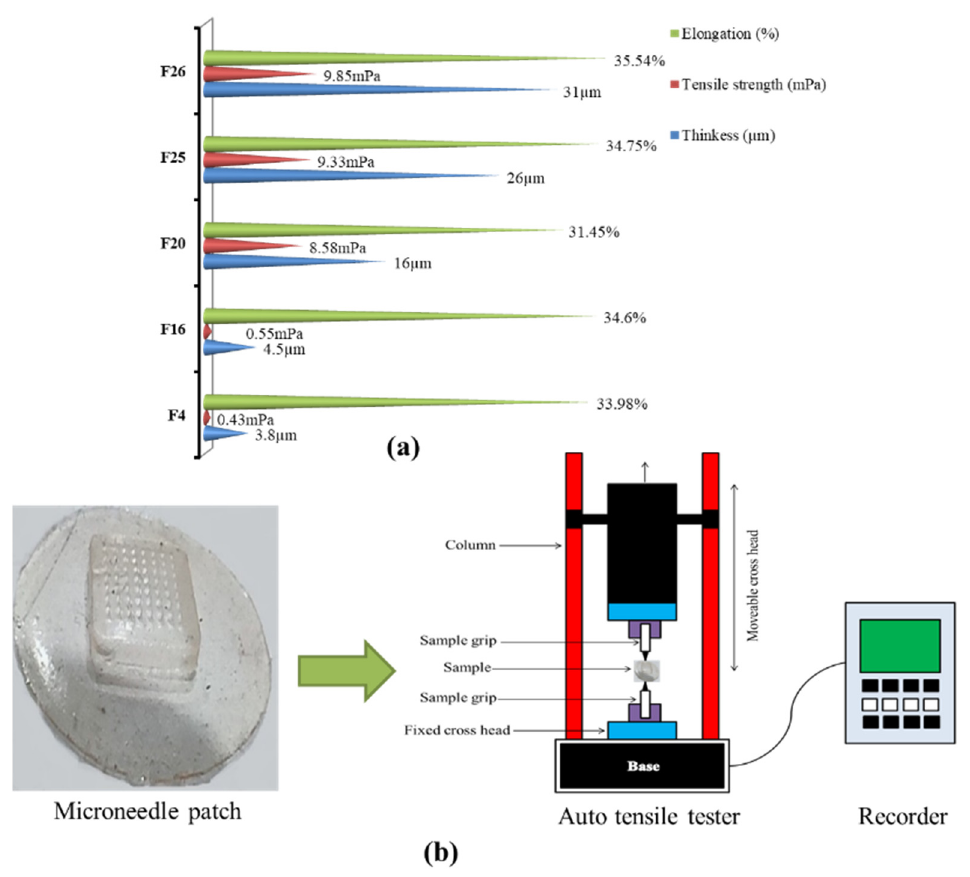
Figure 2. ( a ) Results of thickness, tensile strength and elongation (%), ( b ) schematic diagram to represent measurement of tensile strength and elongation of dMNP.